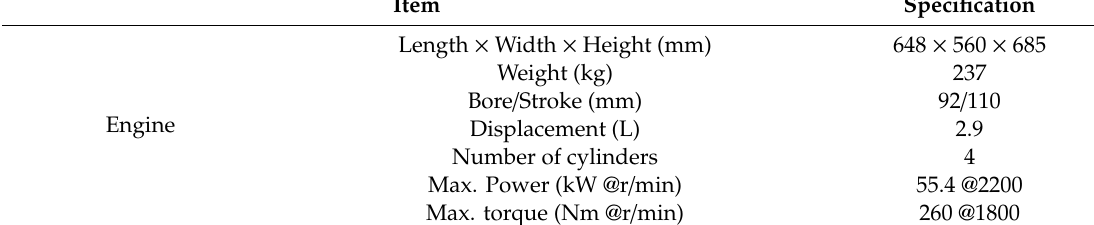
Figure 1. Schematic diagram of the prototype of hydro mechanical transmission (HMT). Table 1. Specifications of the engine and hydrostatic unit (HSU) of the HMT tractor prototype.